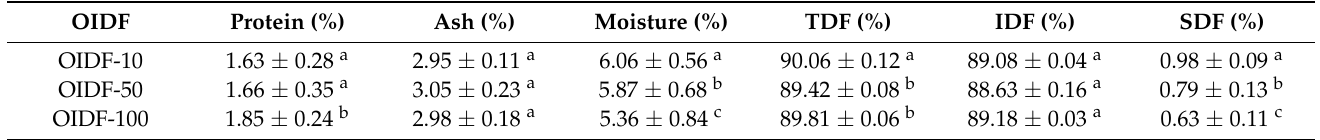
Table 2. Analysis of basic components of OIDF with different particle sizes